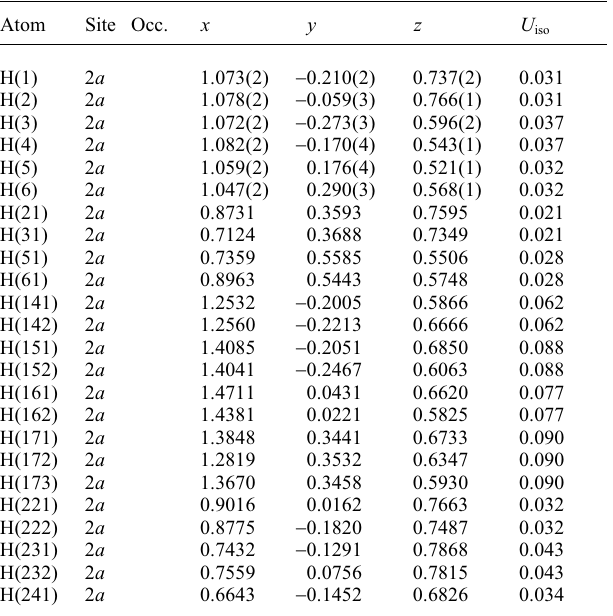
Table 2. Atomic coordinates and displacement parameters (in Å 2 ) .